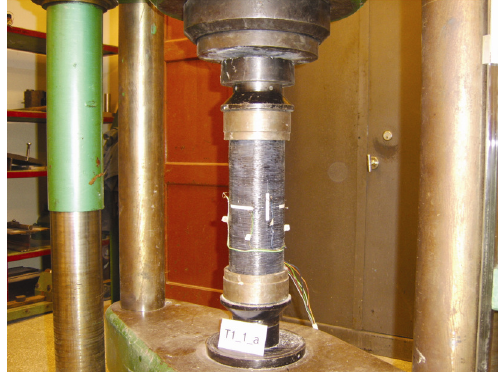
Fig. 2. Specimen T 1_1_a in experimental setup